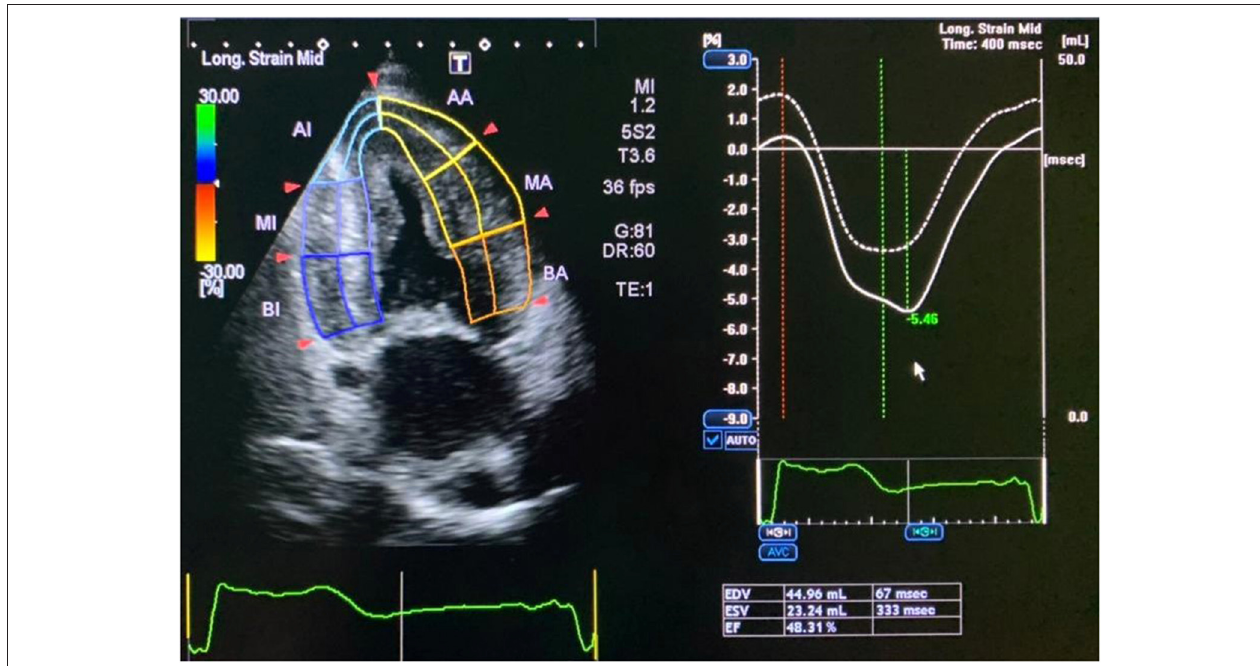
FIGURE 4 | Speckle tracking for two-chamber